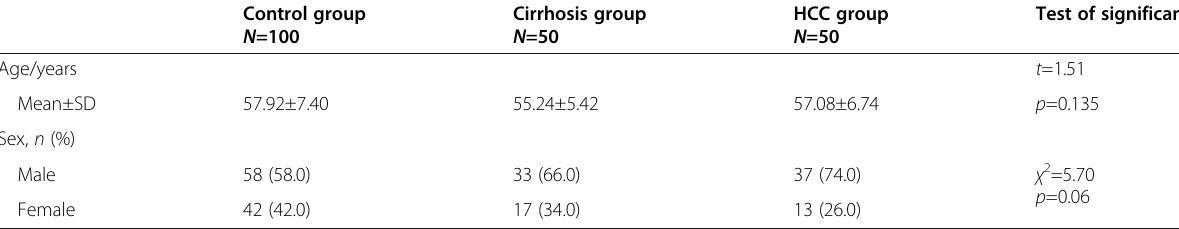
Table 1 Demographic characteristics of the studied groups